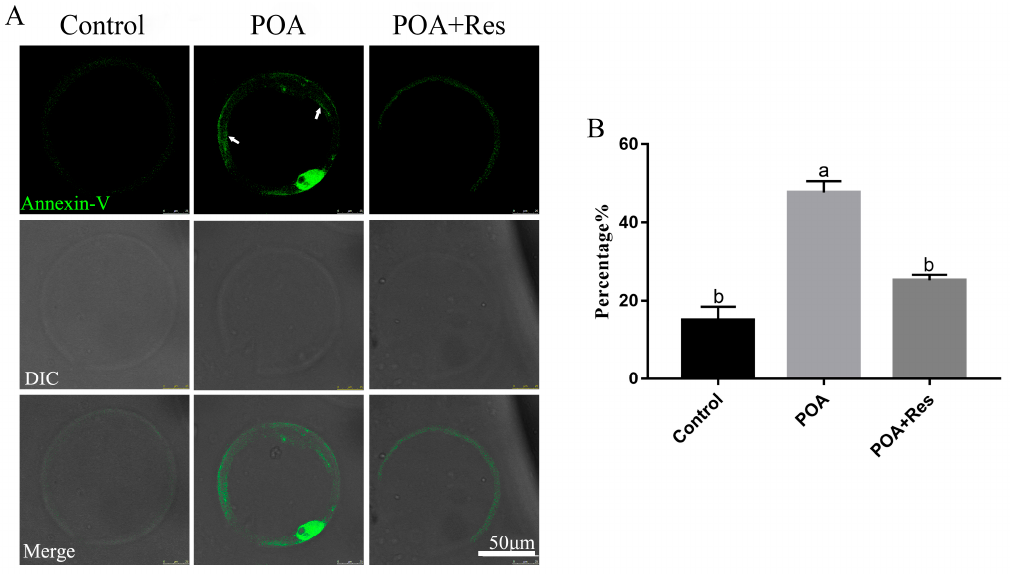
Figure 7. Resveratrol alleviates the apoptosis of POA oocytes. ( A ) Representative images of apoptosis (green) in the control, POA and resveratrol-treated POA (POA + Res) oocytes. The fluorescent signals only at membrane (white arrow) are regarded as early apoptosis. Scale bar = 50 µm. ( B ) The rates of early apoptosis in the control, POA and POA + Res groups. Data are presented as mean ± SEM from at least three independent experiments. a,b means not sharing a common superscript is different; P < 0.05.